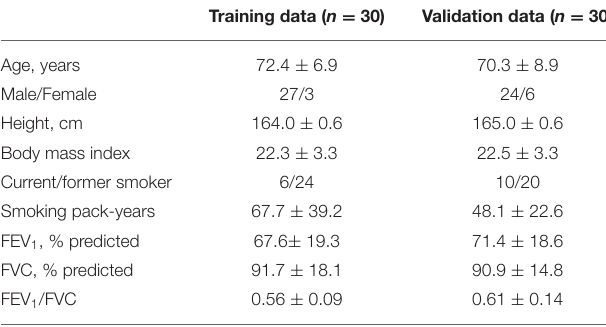
TABLE 1 | Clinical information in two